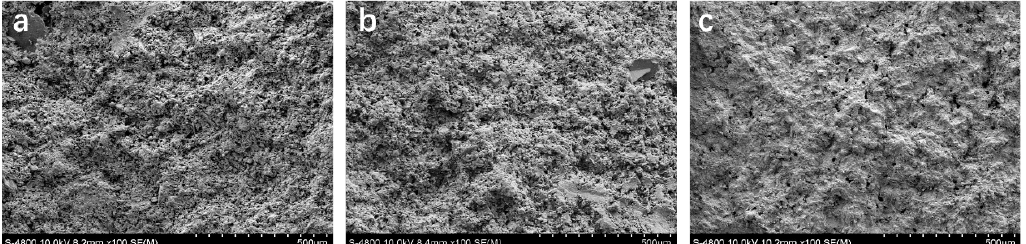
Figure 5. SEM images of the PSCM with the hot–dry temperature of 40 ° C and the solid content of ( a ) 40 wt. %, ( b ) 50 wt. %, and ( c ) 60 wt. %, based on the hot–dry casting process.